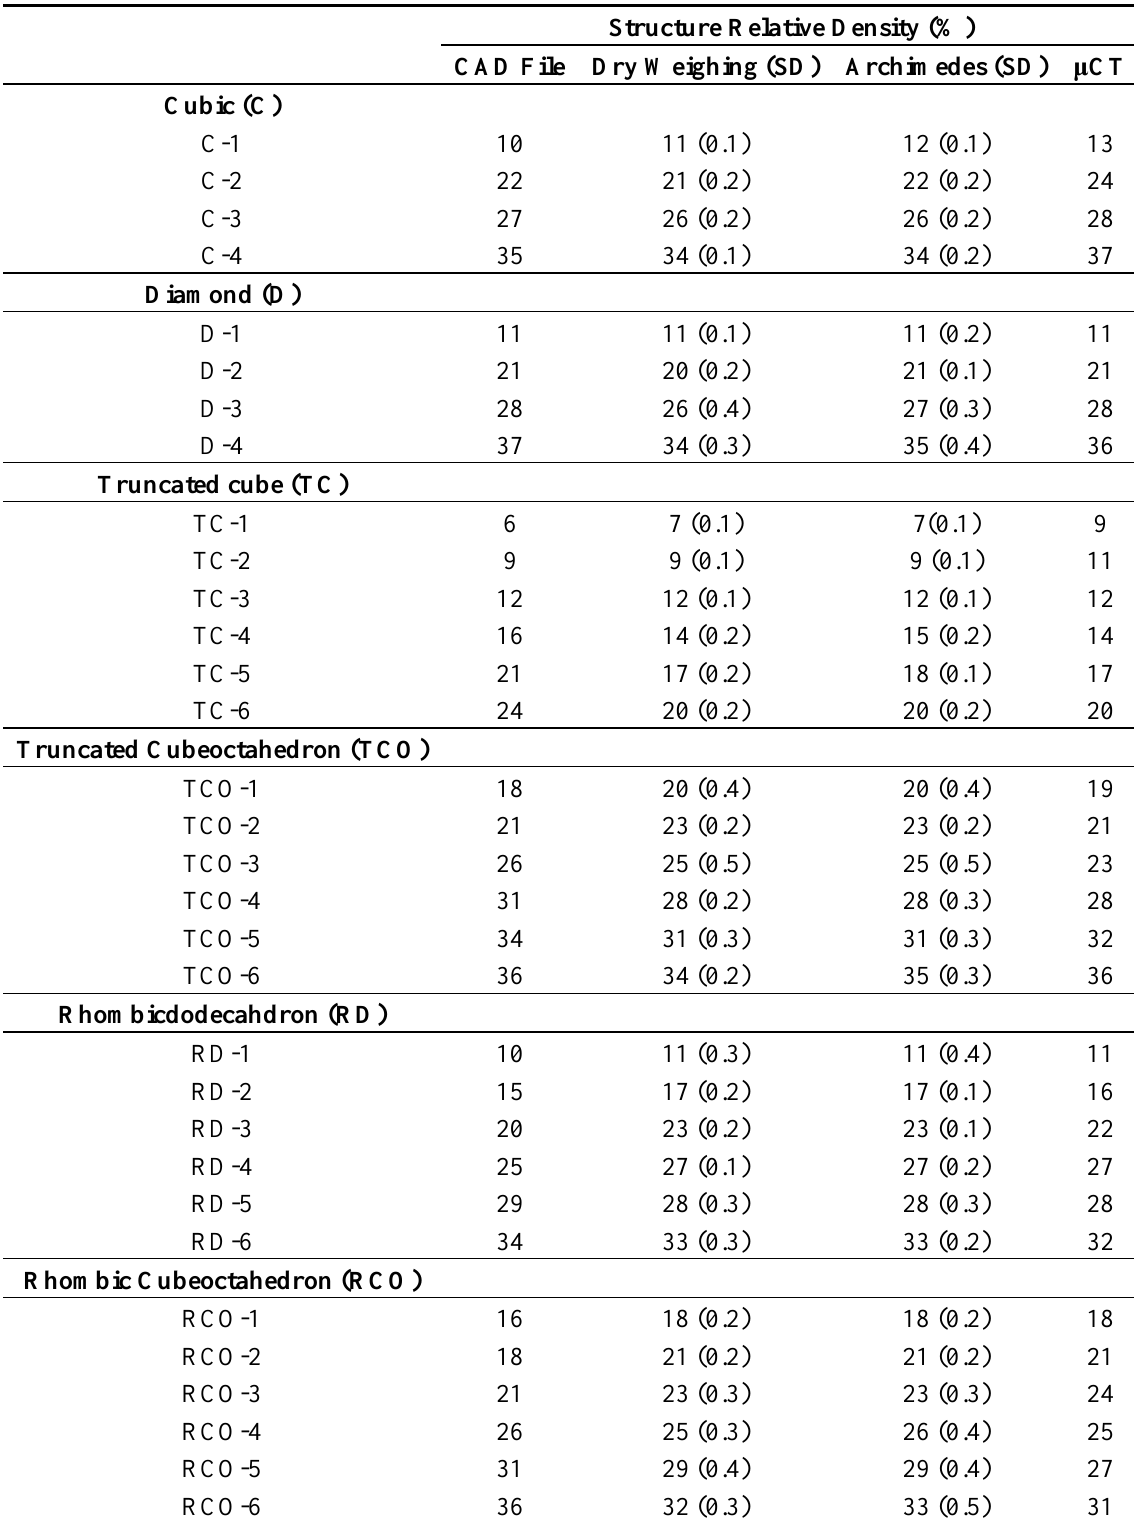
Table 2. Summary of the structure relative density results (in